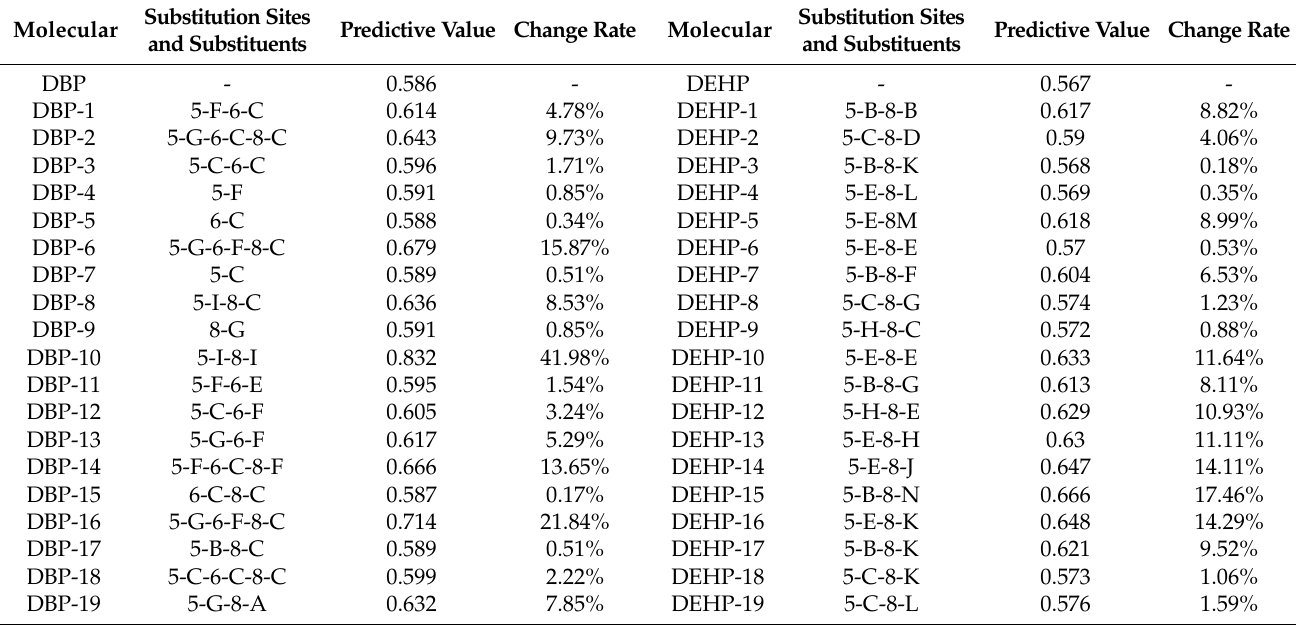
Table 3. Prediction and change rate of molecular biodegradation of DBP and DEHP